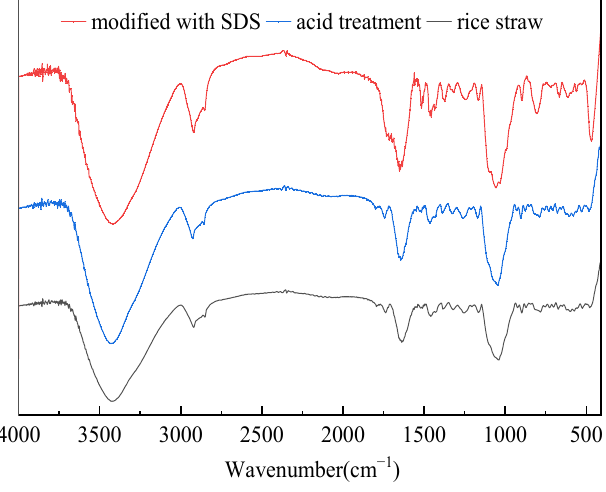
Figure 5. FT-IR spectra of rice straw, acid treatment, and modi fi ed with SDS. The XRD pa tt erns of unmodi fi ed and modi fi ed rice straw in Figure 6 exhibit cellulose I β characteristic peaks at around 2 θ of 21.5°, representing the d 200 crystallographic planes of the monoclinic la tt ice structure [36,37]. Moreover, the crystallinity after